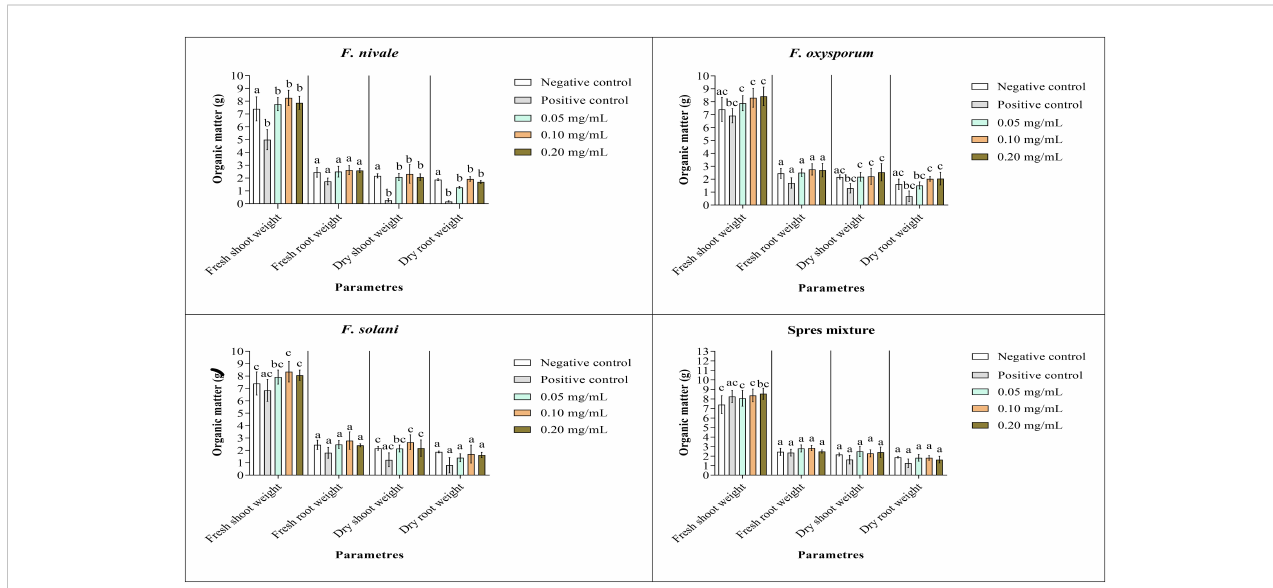
FIGURE 10 Organic matter of ryegrass after four weeks of treatment with carvacrol in disinfected soil under greenhouse. Means (± SD, n = 3) denoted by the same letter indicate no signi fi cant difference according to Tukey ’ s multiple range tests at p< 0.05.